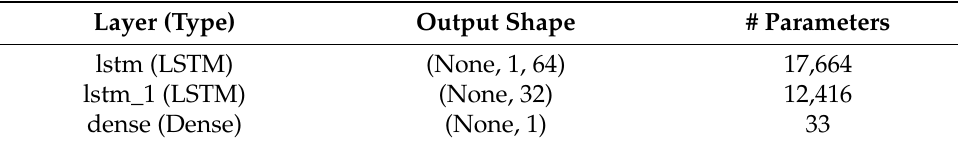
Table 1. The structure information of the LSTM